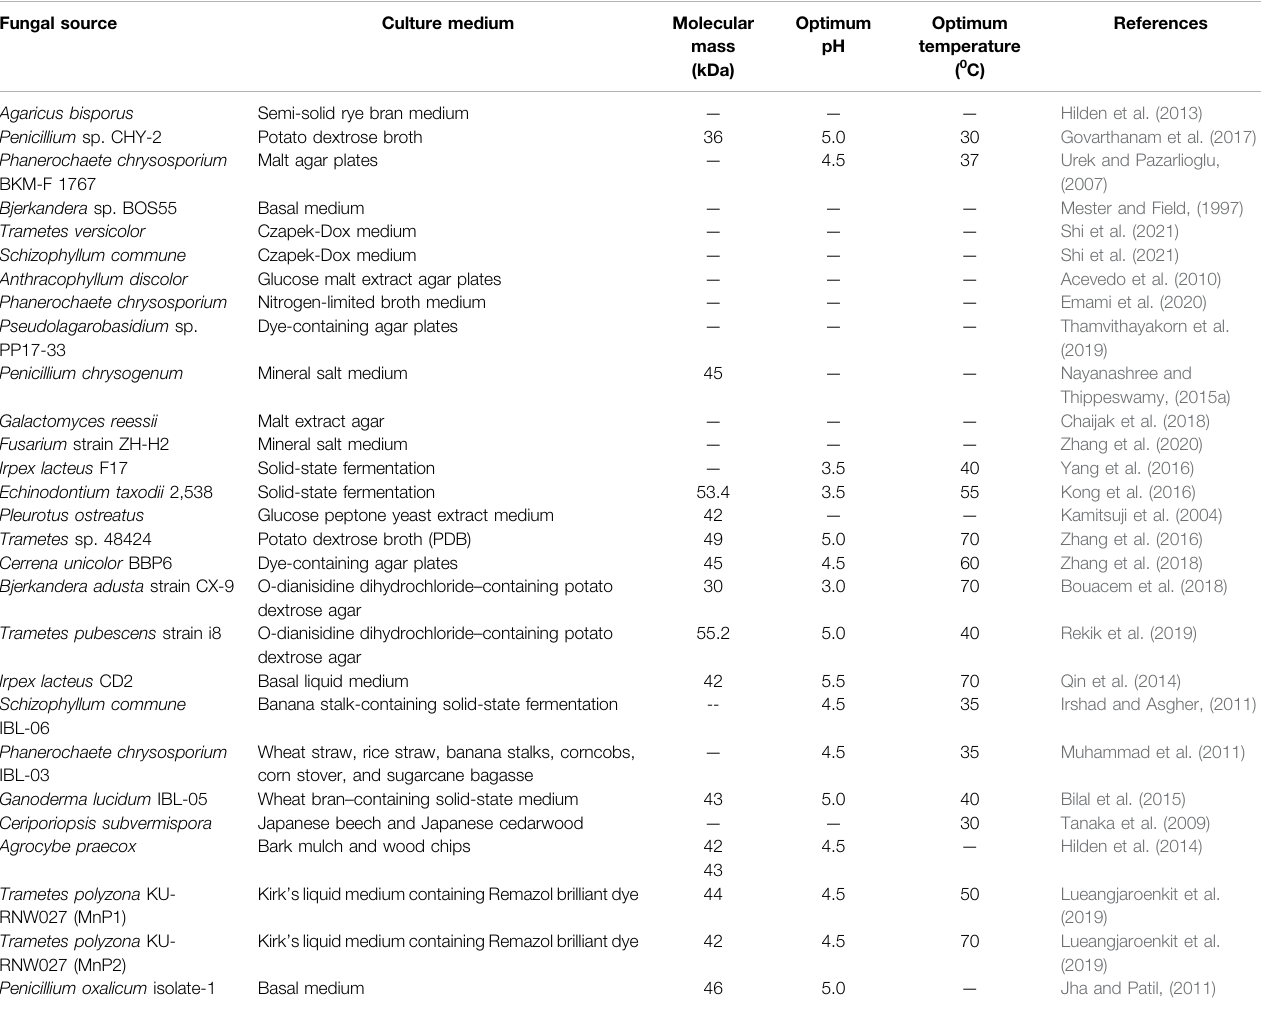
TABLE 1 | List of sources and characteristics of fungal